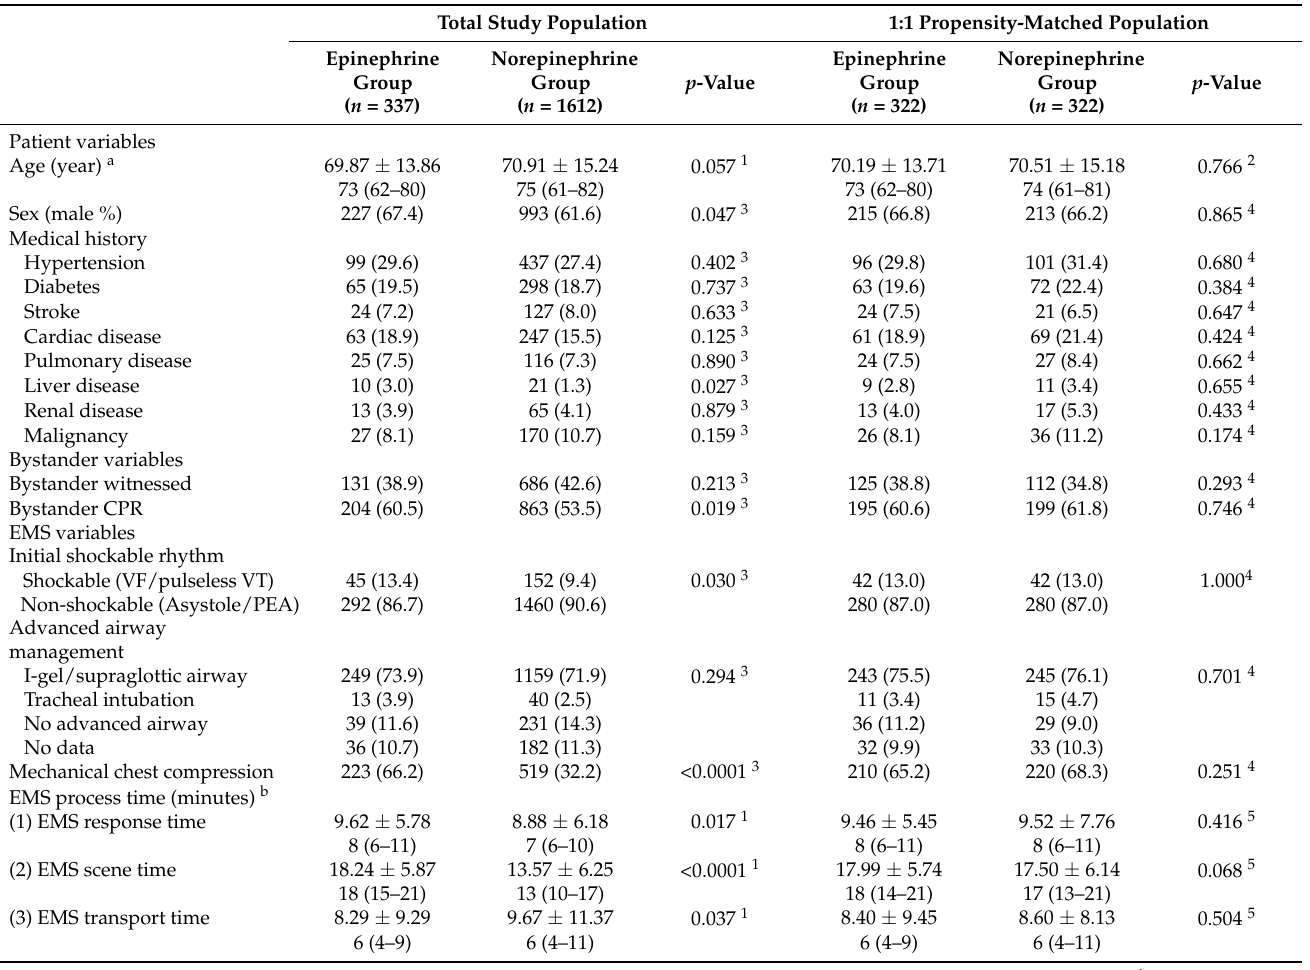
Table 1. Characteristics of the total study population and propensity-matched population according to prehospital epinephrine administration by EMS providers.